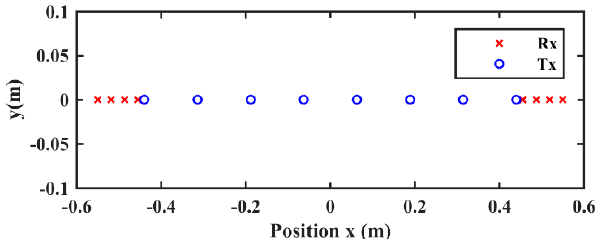
Figure 4. Topology of the designed MIMO sparse array.